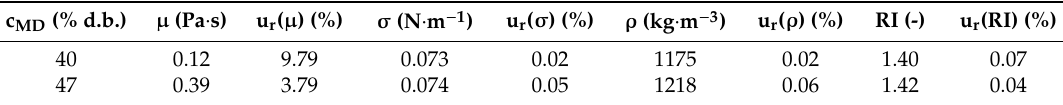
Table 1. Physical properties: viscosity ( µ ), surface tension ( σ ), density ( ρ ) and refractive index (RI), as well as corresponding uncertainty values u r ( γ ) of test solutions at 25 ◦ C. Dry matter content c MD is given as dry base value (d.b.).